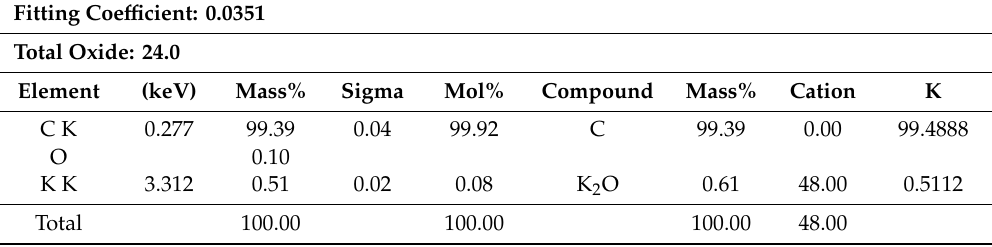
Table 9. The Oxide of resin reinforced Coco-husk ( Cococs nucifera